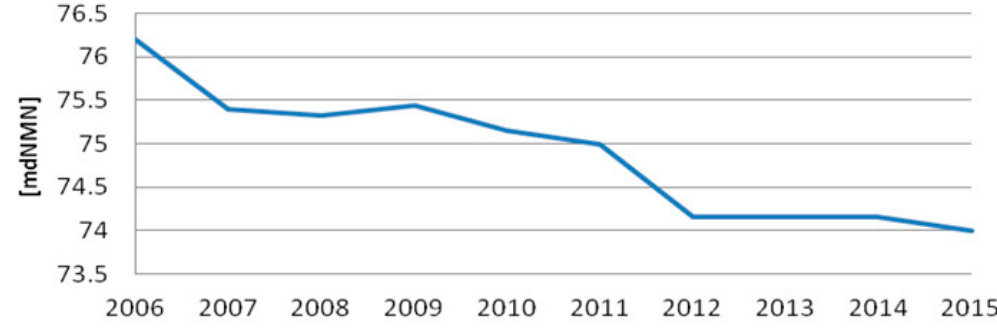
Figure 3. Water level in Circului Lake between 2006 and 2015 (modified after [38]).